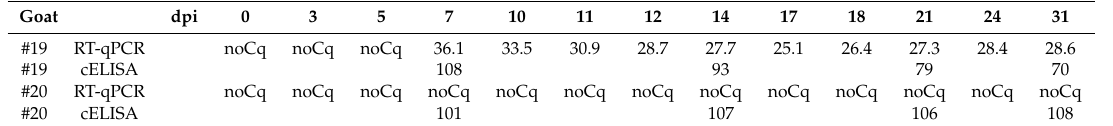
Table 4. Results from experimental inoculation of goats. RT-qPCR (Cq-value) and cELISA (S / N%) results after diagnostic inoculation of two goats (#19 and #20) are